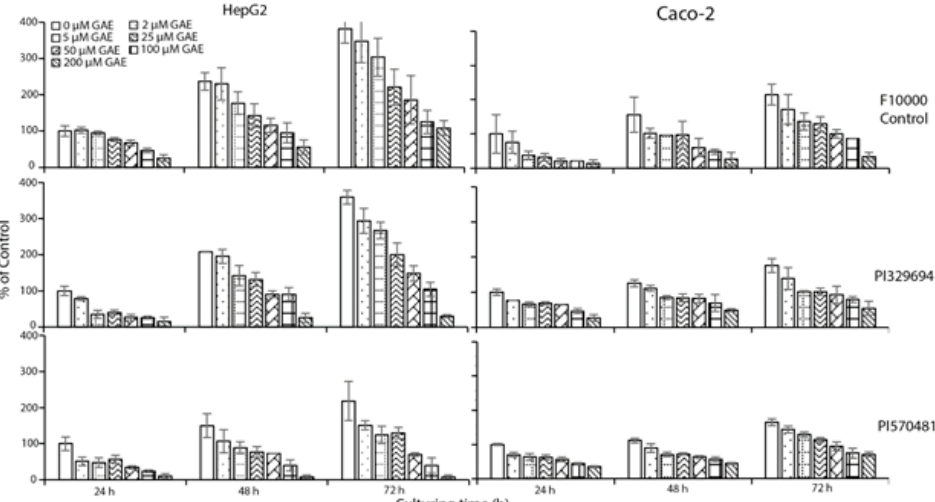
Figure 2. The effect of representative sorghum phenolic extracts at 0–200 μ M GAE for up to 72 h on cell number in both HepG2 and Caco-2 cells. Cells were treated with sorghum phenolics extracted from the representative sorghum accessions PI329694 and PI570481 at various concentrations (0–200 μ M GAE) for up to 72 h in 6-well plates, then detached by trypsin-EDTA solution, and the cell number was counted by hemacytometer at each timepoint. Values are expressed as a percentage of the untreated control at 24 h by Mean ± SD ( n = 3). The significance of the trend for cell growth inhibition at various concentrations at each timepoint was analyzed with linear regression, p < 0.05.